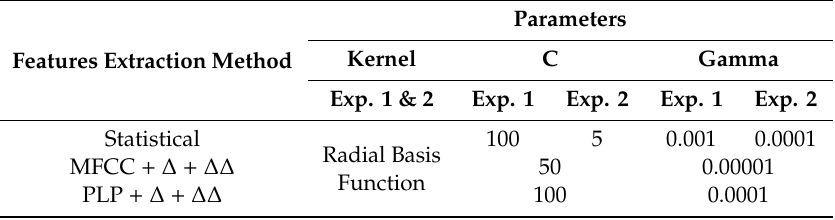
Table 2. Parameters setting for the support vector machine (SVM)